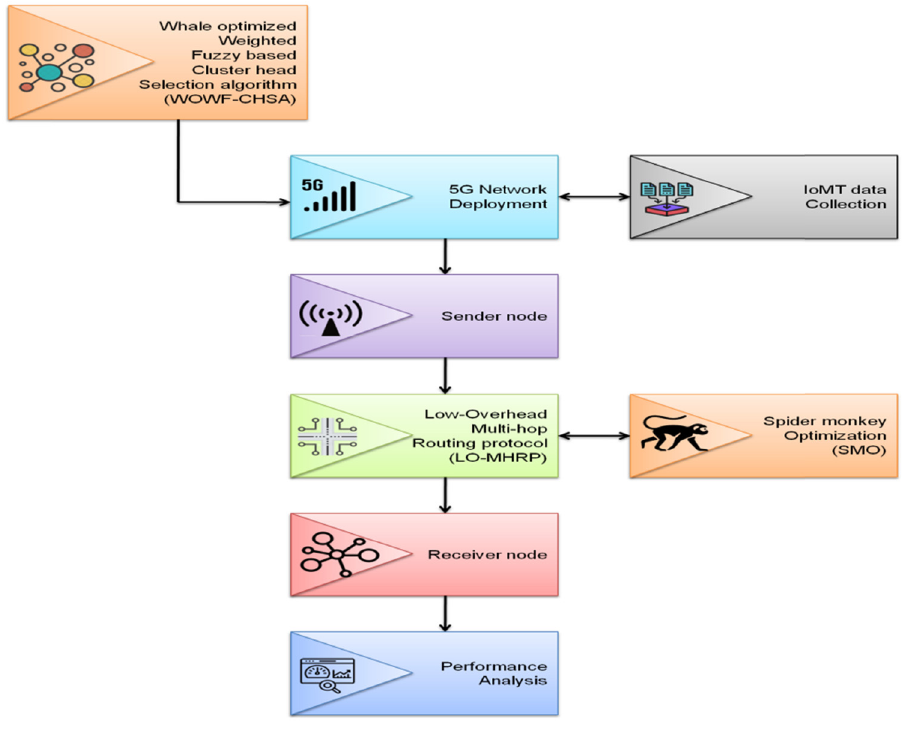
Figure 3: The fl ow of the proposed